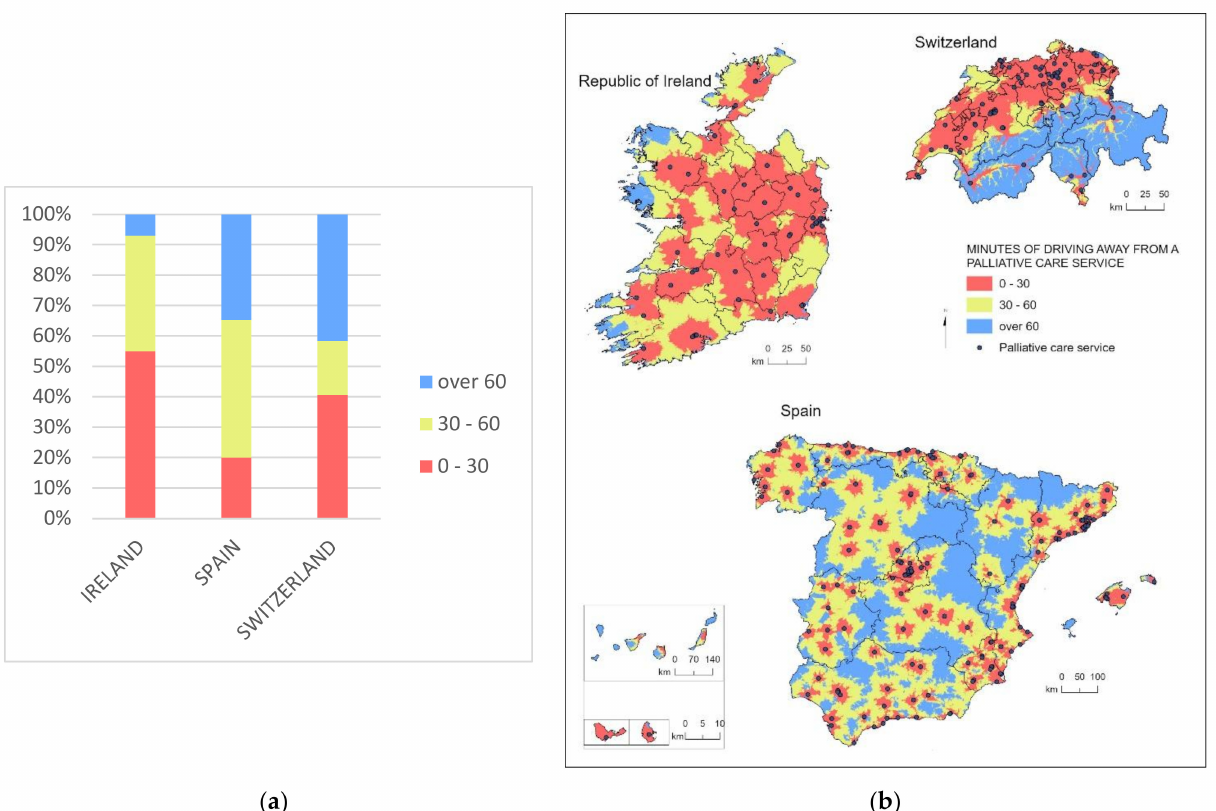
Figure 1. Surface coverage of specialized Palliative Care services (driving time to services). ( a ) Stacked bar chart showing the percentage of surface coverage per distance range in time per country; ( b ) map of the surface coverage of different distance times to the nearest palliative care